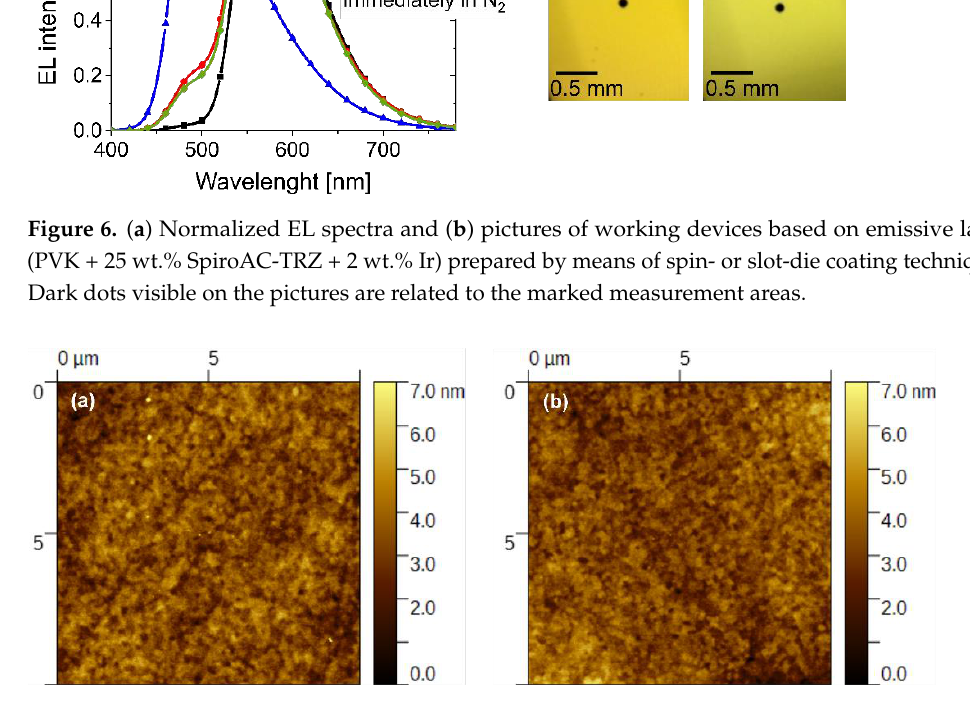
Figure 8. Working parameters of OLEDs based on emissive layer (PVK + 25 wt.% SpiroAC-TRZ + 2 wt.% Ir) prepared by means of spin- or slot-die coating technique. Device structure: ITO/PEDOT:PSS (20 nm)/EML (75 nm)/Bphen (40 nm)/Liq (2 nm)/Ag (100 nm). ( a ) Current density – voltage charac- teristics (left) and luminance – voltage characteristics (right); ( b ) Current efficiency vs. current den- sity. Previously, the time of the sample exposure to oxygen influence was not controlled and EML was annealed in the glovebox at an unspecified delay after the deposition (re- sults depicted by red curves in Figures 6a and 8). Therefore, to check the oxygen impact,